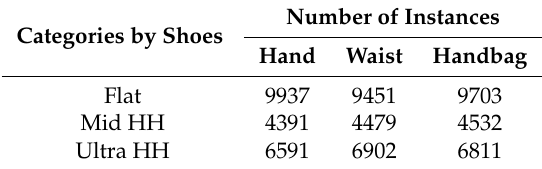
Table 5. The instances of different shoes categories (sliding windows of 200 samplings, 2 s).